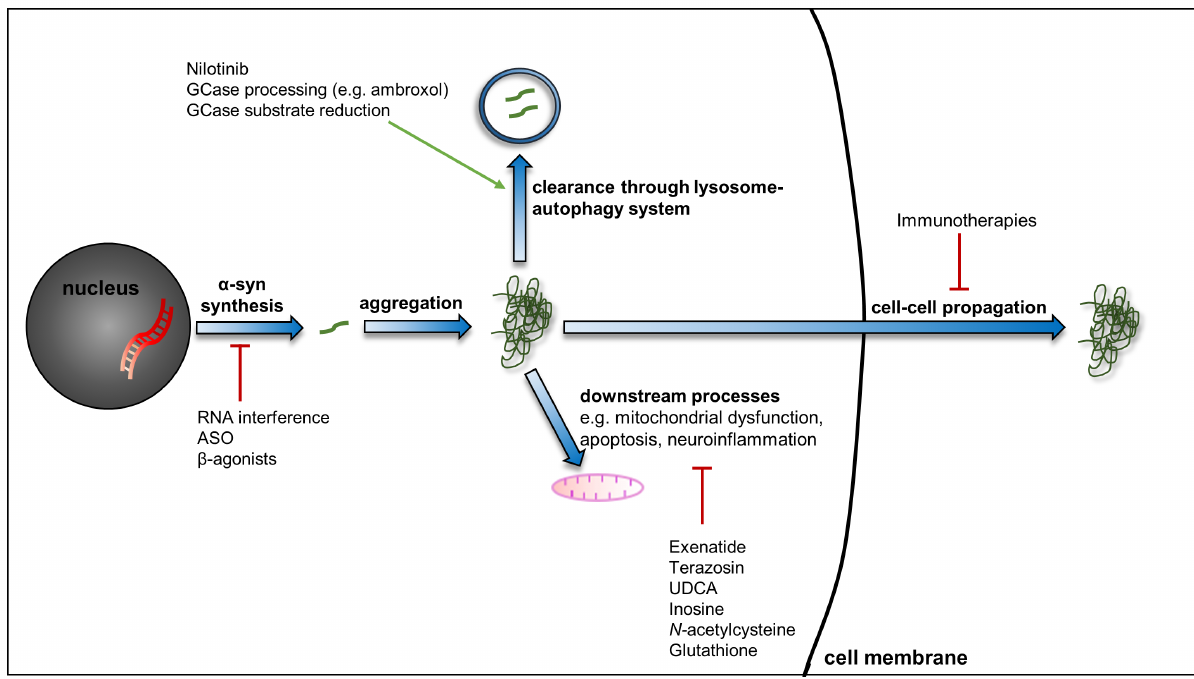
Figure 1. Putative disease-modifying therapies for PD. An expanding number of drugs are being considered for their ability to influence the pathogenic processes of PD. These include novel agents and technologies, such as active and passive immunisation and RNA interference techniques to limit the propagation, and synthesis, of α -synuclein. Additionally, several drugs used for other conditions are of interest for potential use in PD given their ability to influence pathways such as the lysosome–autophagy system, mitochondrial function, and neuroinflammation, for example. Abbreviations: α -syn, α -synuclein; ASO, anti-sense oligonucleotide; GCase, glucocerebrosidase; PD, Parkinson’s disease; RNA, ribonucleic acid; UDCA, ursodeoxycholic